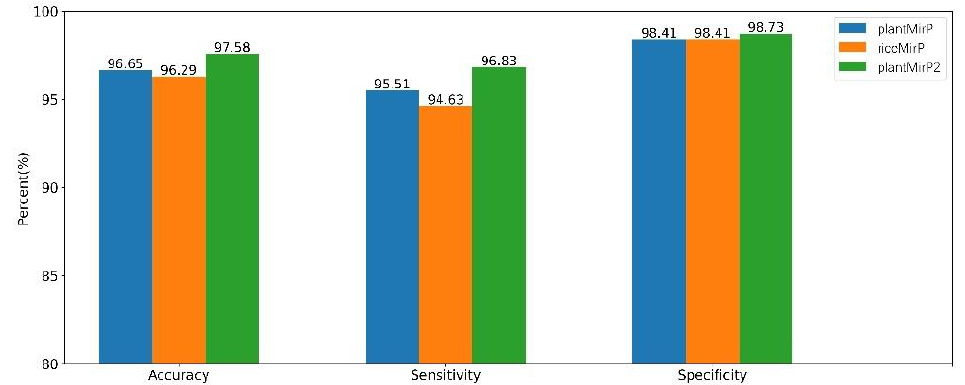
Figure 5. Based on the same training dataset and testing dataset, indicators of plantMirP, riceMirP and plantMirP2 were compared.